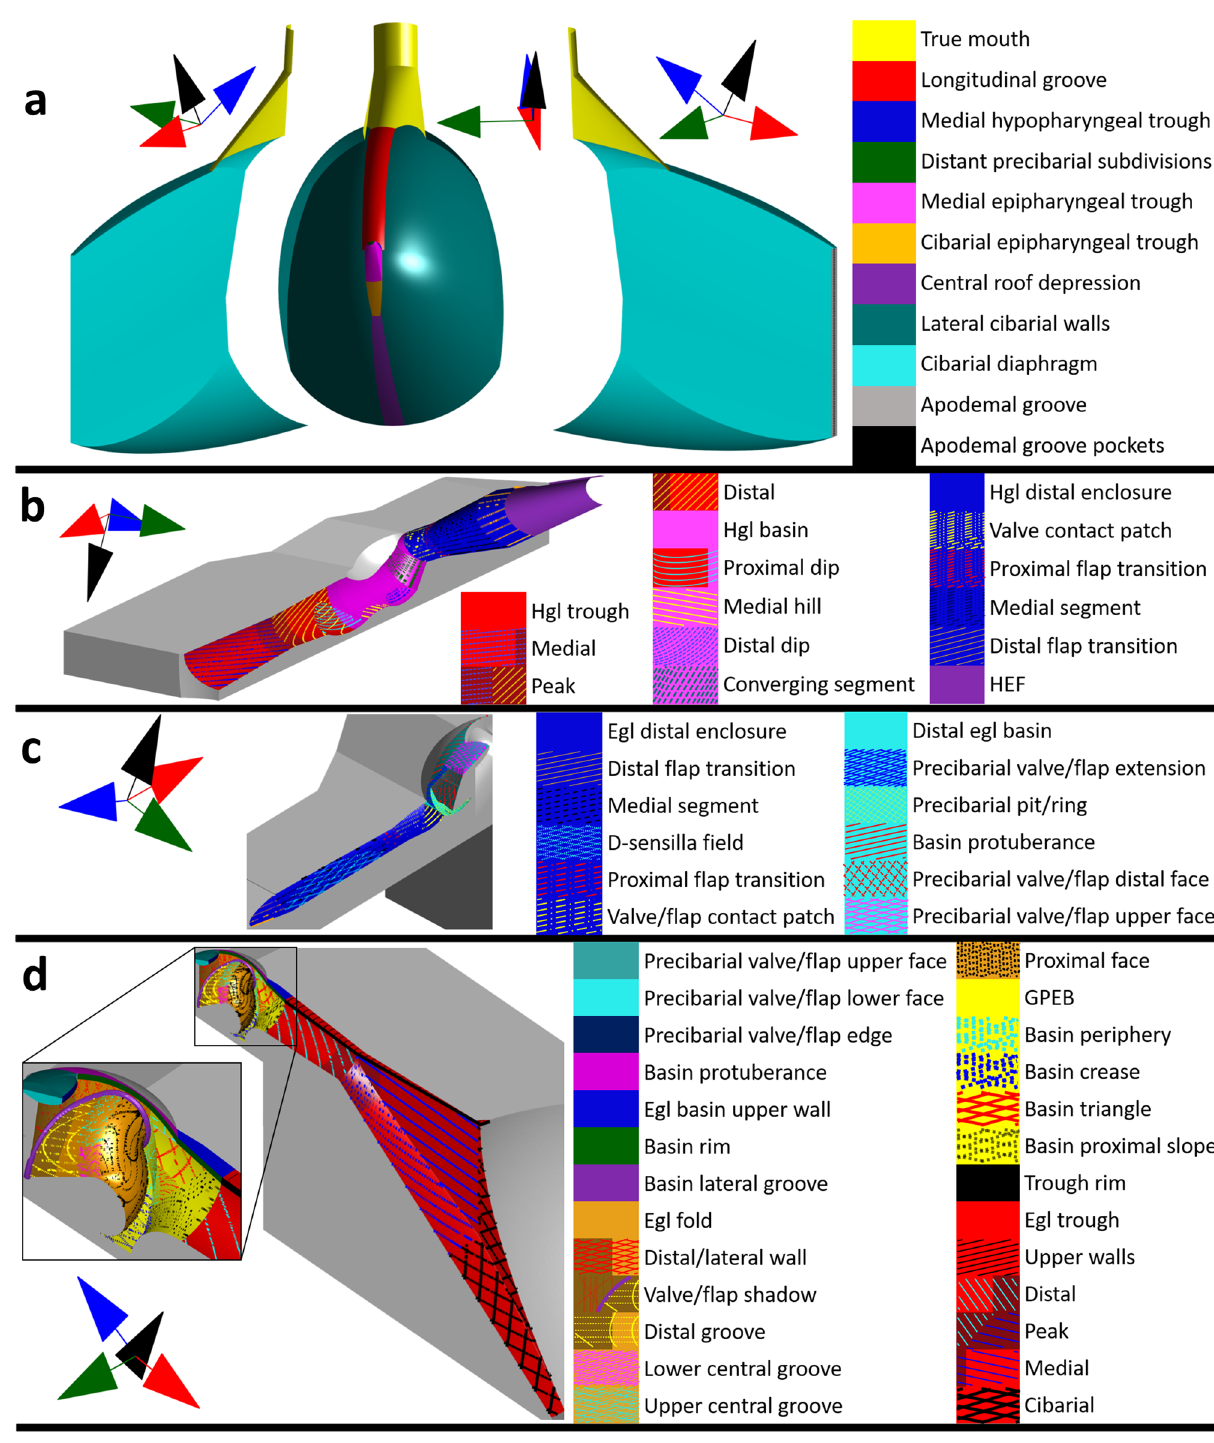
Figure 4. Fine resolution terminology for the cibarium and precibarium of the blue–green sharpshooter. In this figure, all model views are internal. ( a ) Cibarium bowl (concave, with the cibarial diaphragm and true mouth split outward, like classic plantation shutters (concave). ( b ) Left half of the hgl precibarium (concave). ( c ) Left half of the egl distal enclosure (concave) and distal egl basin (partially concave and partially convex). ( d ) Left half of the egl trough and part of the egl basin (the egl fold and basin protuberance are convex, and the rest is concave). The egl fold lateral groove was modified for the sake of illustration. The coordinate axes indicate anterior → posterior, distal → proximal (for the trough), ventral → dorsal, and left → right. The gray 3D parts of subfigures b–d are abstract representations of the epipharynx and hypopharynx. Hgl: hypopharyngeal; egl: epipharyngeal; GPEB: groove at the proximal end of the basin; HEF: hypopharyngeal extension that inserts into the stylet food